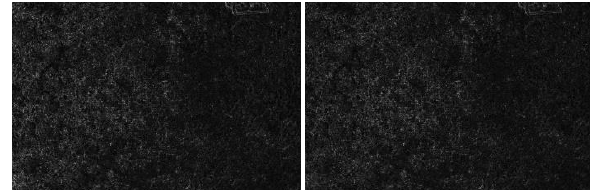
Figure 8. Absolute intensity differences between the ground truth images and the refraction corrected images in each iterations (left: first iteration, right: second iteration). For a better visualization, all the values have been amplified with the factor of 10.